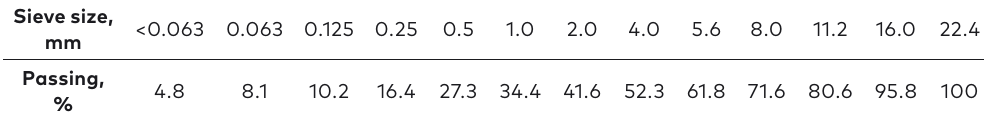
Table 2. Gradation table for HMAC 16 25/55-60 mixture